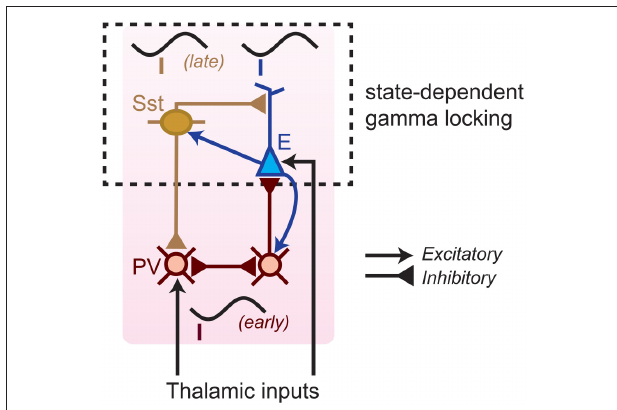
FIGURE 12 | Hybrid model of S1BF gamma generation. A class of FS interneurons (red; presumably Parvalbumin-positive cells) has strong mutual inhibitory connections, and does not have a substantial projection to other FS interneurons ( Pfeffer et al., 2013). These FS cells receive both excitatory drive from thalamic projections and from local recurrent excitatory inputs. Due to the mutual inhibitory connections, the FS cell network starts firing gamma synchronously and also entrains the excitatory cells. The excitatory cells fire at a slightly later phase because the inhibitory synaptic potentials from I → E connections are slower than the I → I connections ( Wang and Buzsaki, 1996; Bartos et al., 2007 ). Another group of FS cells (yellow, presumably Somatostatin-positive cells) relies on the local excitatory cells to be entrained to the gamma rhythm, does not receive a substantial thalamic drive, and does not exhibit strong gamma phase locking. These cells fire late in the gamma cycle, few milliseconds after the excitatory cells, and might help to shut down the activity of both the early firing FS cells and the excitatory cells ( Pfeffer et al., 2013). Early-firing FS cells show little state-dependence, whereas excitatory and late-firing FS cells show strong state